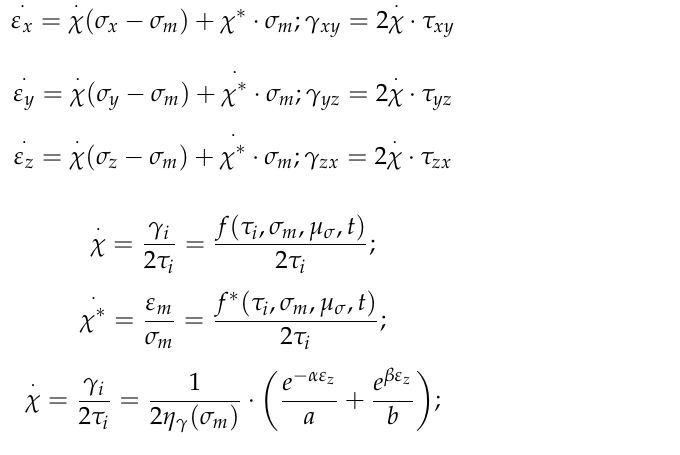
4), kinematic shear τ –t at different ( γ · = const ) (see Figure 5a), and relaxation τ –t at different